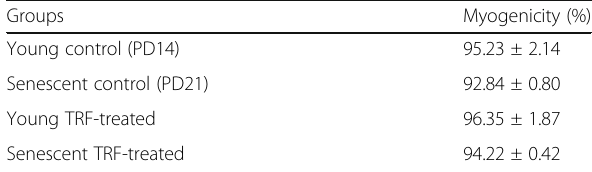
Table 3 Myogenic purity of myoblasts in culture